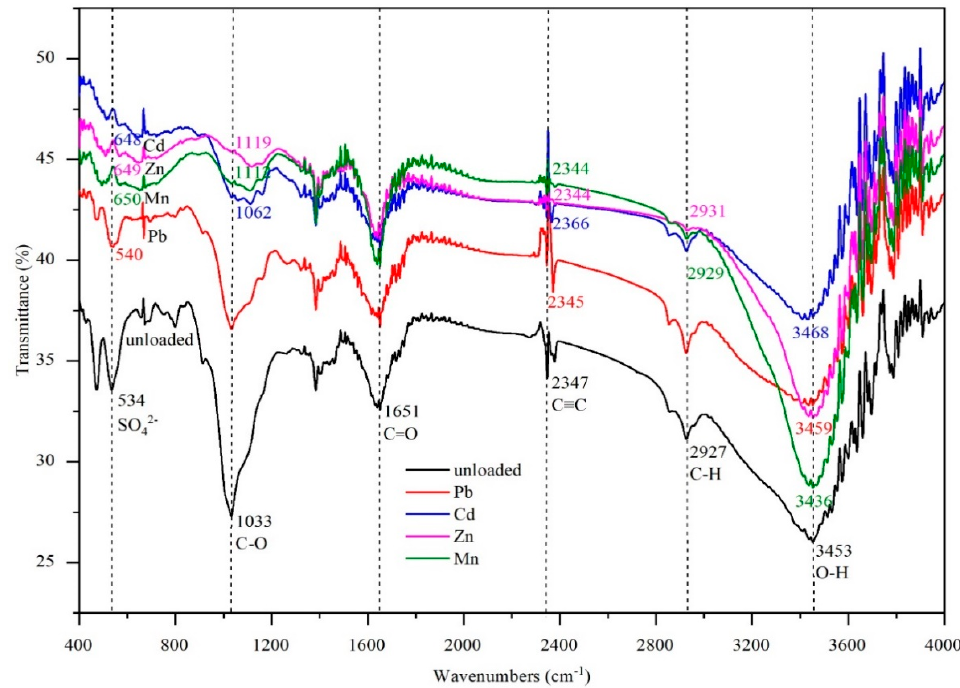
Figure 2. Fourier-Transform Infrared Spectrometry (FTIR) spectra of the roots of Eichhornia crassipes after uptake of Pb, Zn, Cd, and Mn.